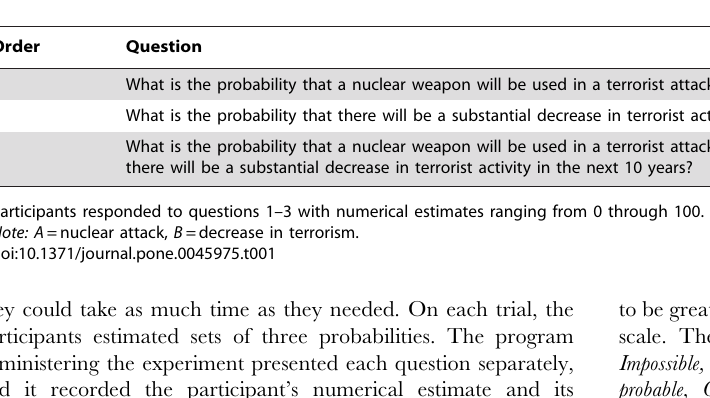
Table 1. An example of a problem in Experiment 1, and its abstract form.